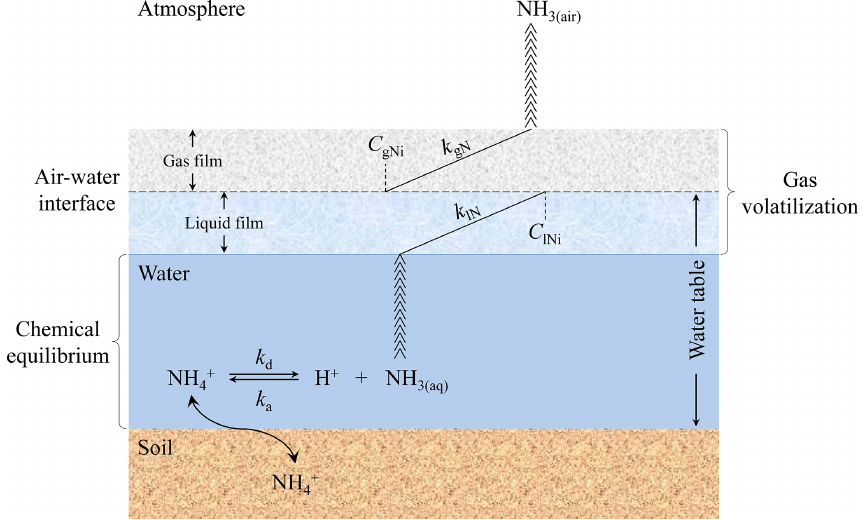
Figure 1. Mechanism of the Jayaweera–Mikkelsen model introduced into the modified CNMM–DNDC; k d and k a refer to the dissociation and association rate constants for NH + –NH 3 chemical equilibrium, respectively; k lN and k gN refer to the exchange constants for NH 3 in 4 the liquid and gas films, respectively. C lNi and C gNi refer to the average concentrations of NH 3 at the interface in the liquid and gas films, respectively. NH 3 ( aq ) and NH 3 ( air ) refer to the average concentration of NH 3 in aqueous and gas phases,